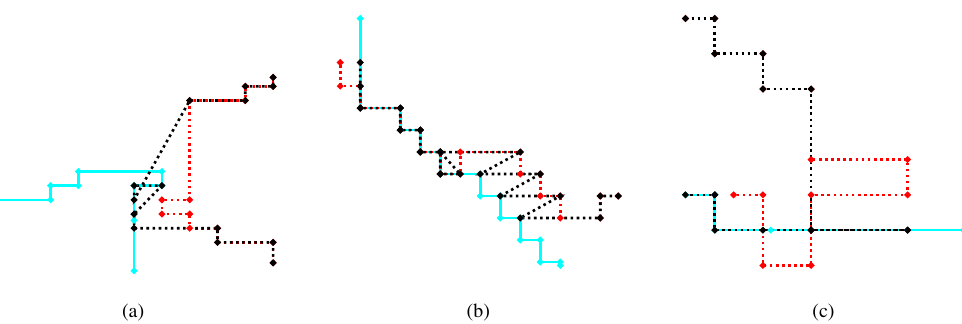
Figure 4. Types of twists: a) real twist; b) backward projection; c) leak. The light blue polygon denotes P target , the red polygon the initial P trigger and the black polygon denotes the projected P trigger .